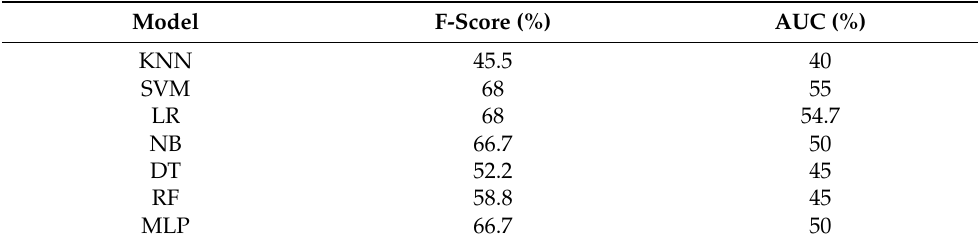
Table 7. Algorithmic performance for ‘StockTwits with VADER’ dataset.